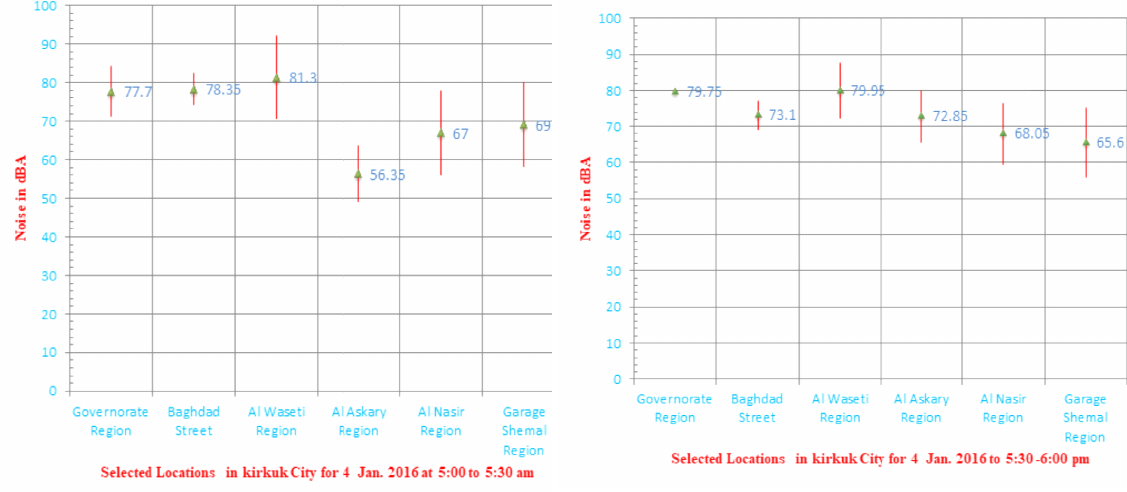
Fig. 12. Max , Min and Average Hourly Noise Distribution for the traffic flow 4 Jan. 2015 Kirkuk City.